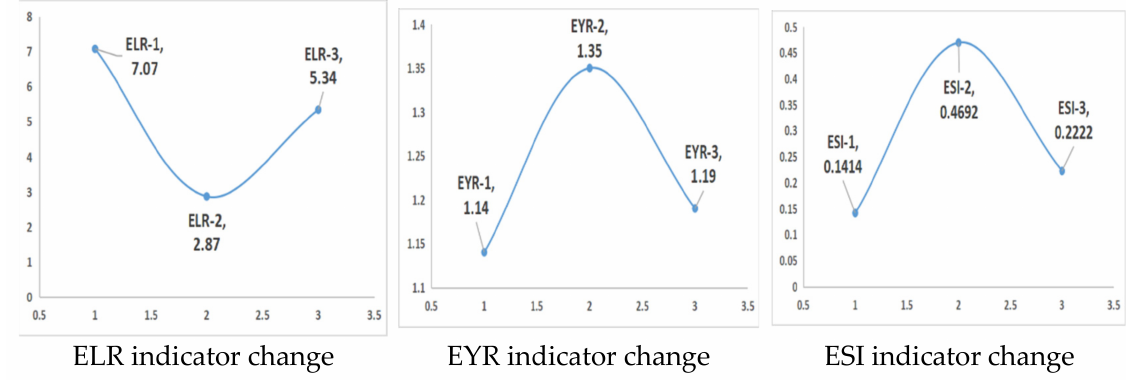
Figure 10. Key indicators comparison.